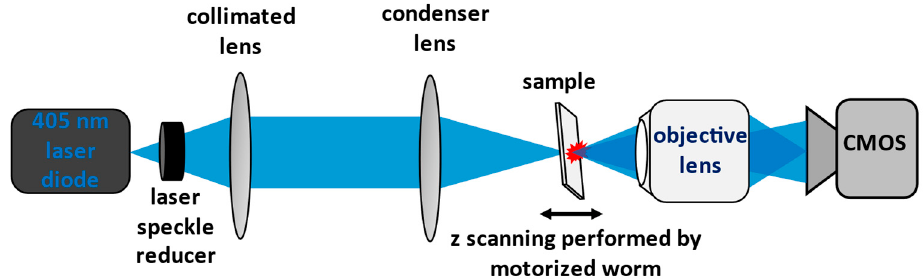
Figure 1. Brightfield optical microscope in transmission mode.